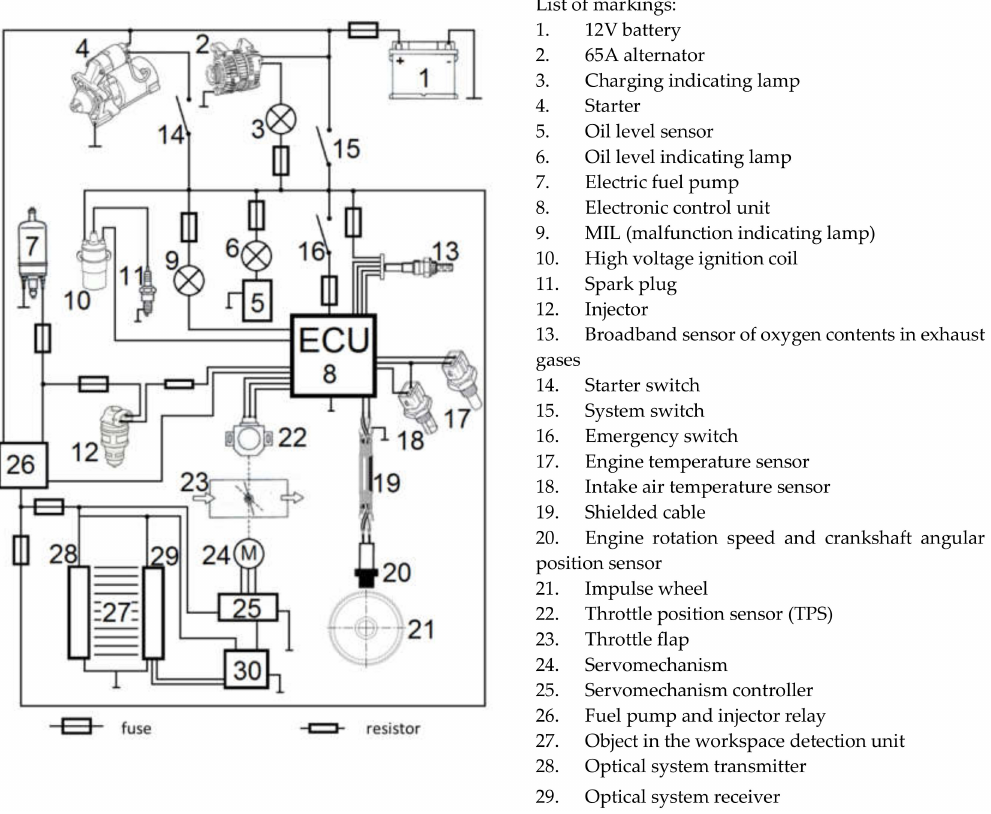
Figure 2. Schematic of the innovative injection-ignition system used in the German GX390 with a maintenance-free detection and adaptive chipper drive control